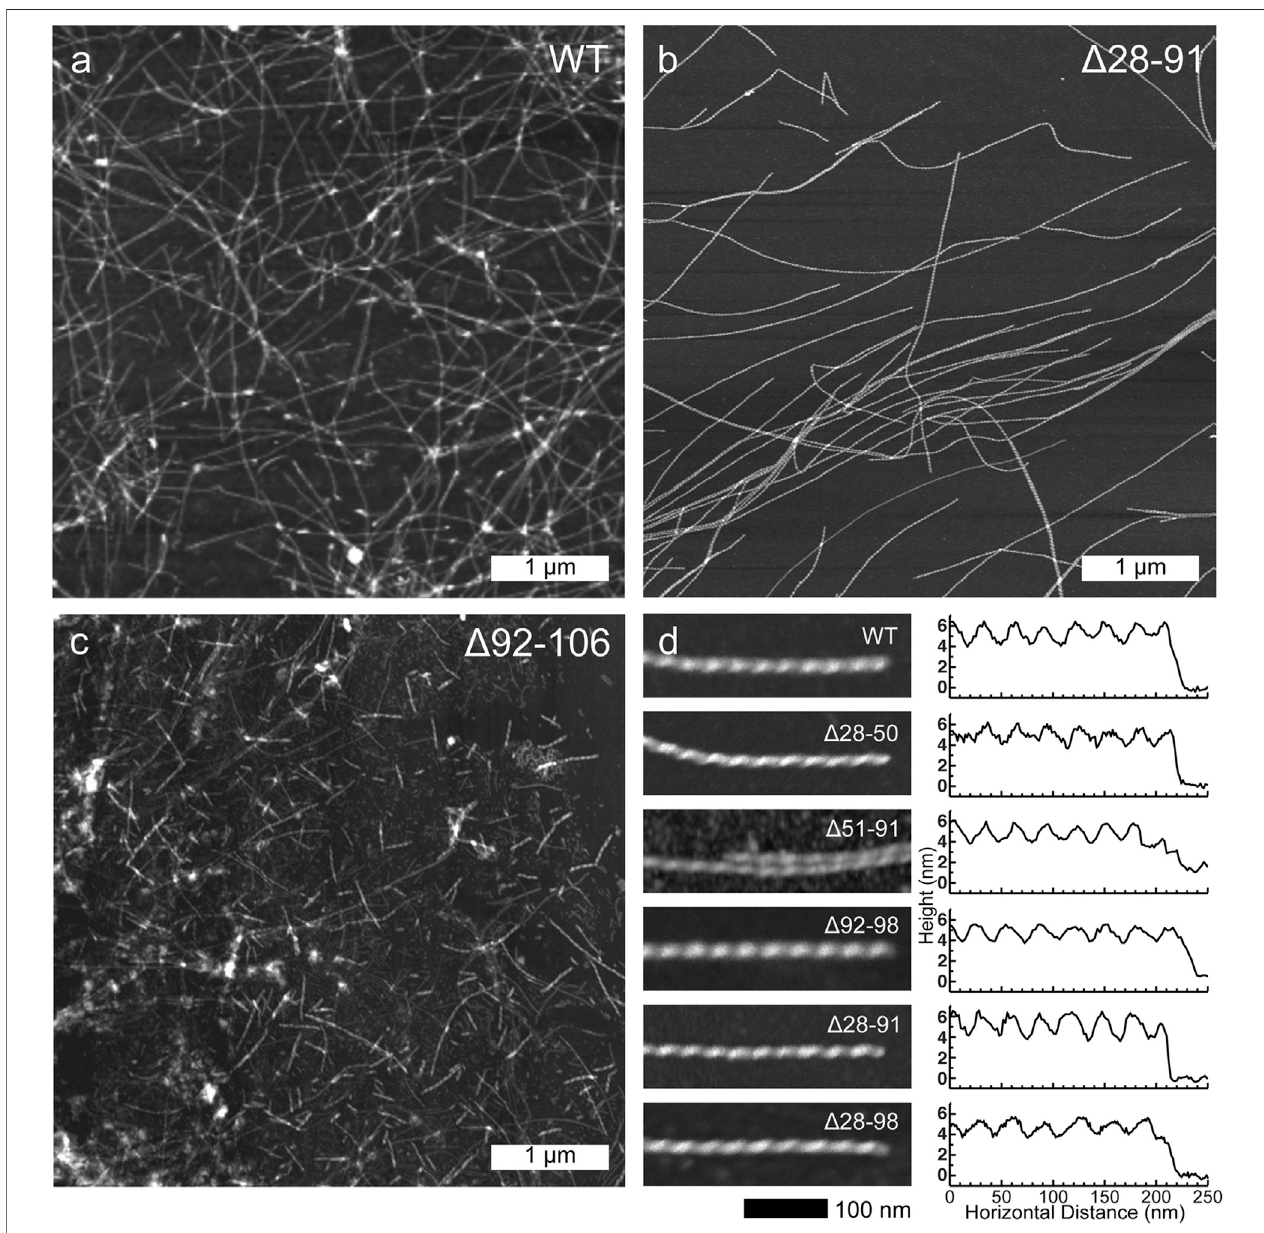
FIGURE 2 | Representative low-resolution atomic force microscopy images for (A) WT, (B) Δ 28-91 and (C) Δ 92-106 huPrP23-144 fi brils (scale bar 1 μ m for all panels). (D) High-resolutionatomicforcemicroscopyimages(left;scalebar100 nmforallpanels)andcorrespondingheightpro fi les(right)forWT, Δ 28-50, Δ 51-91, Δ 92- 98, Δ 28-91, and Δ 28-98 huPrP23-144 fi brils as indicated in the